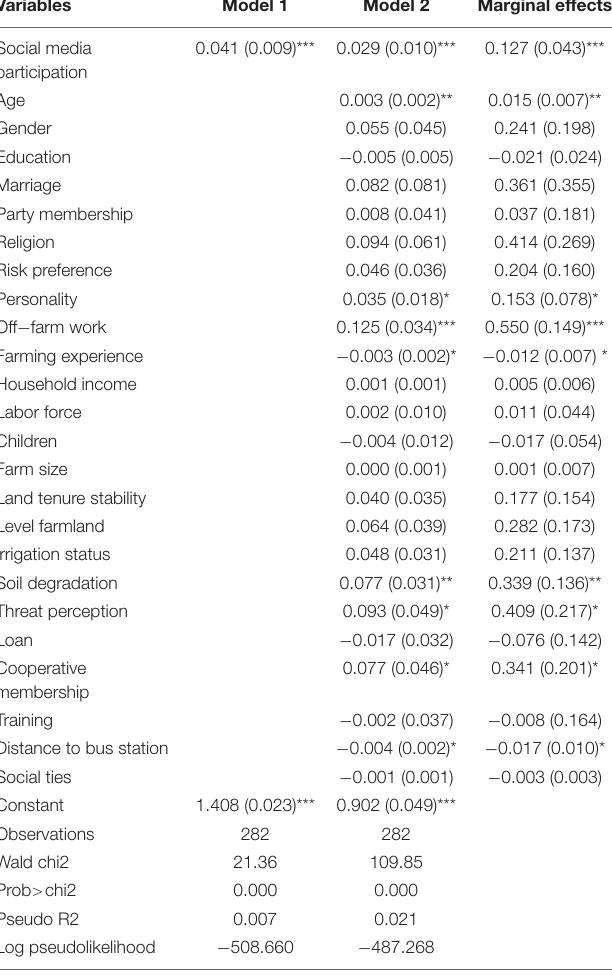
Figure 1 . The value of adoption intensity actually ranges from 2 to 8, as each banana farmer has adopted at least two LAPs according to our survey. The mean number of LAPs adopted is about 4.46 ( Table 2 ). Figure 1 also reveals that 2.30% adopted two LAPs, while the majority (93.97%) of the banana farmers adopted 3–6 LAPs. About 3.90% of banana farmers used 7–8 LAPs in the study